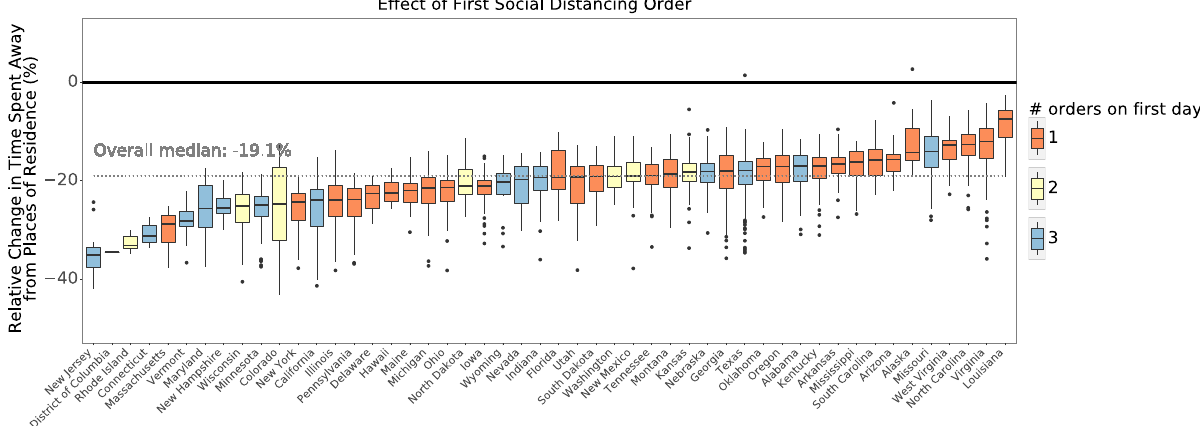
Fig. 3 Effect of the fi rst social distancing order on time spent away from places of residence by state. Color coding re fl ects the number of social distancing policies that were simultaneously enacted in each state. Boxplots indicate the 25th and 75th percentiles (box extent) and the median (center line of each box) of county-speci fi c changes. The whiskers extend from the hinge to the largest value no further than 1.5× interquartile range from the hinge. Dots represent outliers beyond the whiskers. N = 2810 counties in 50 US states and Washington, DC.